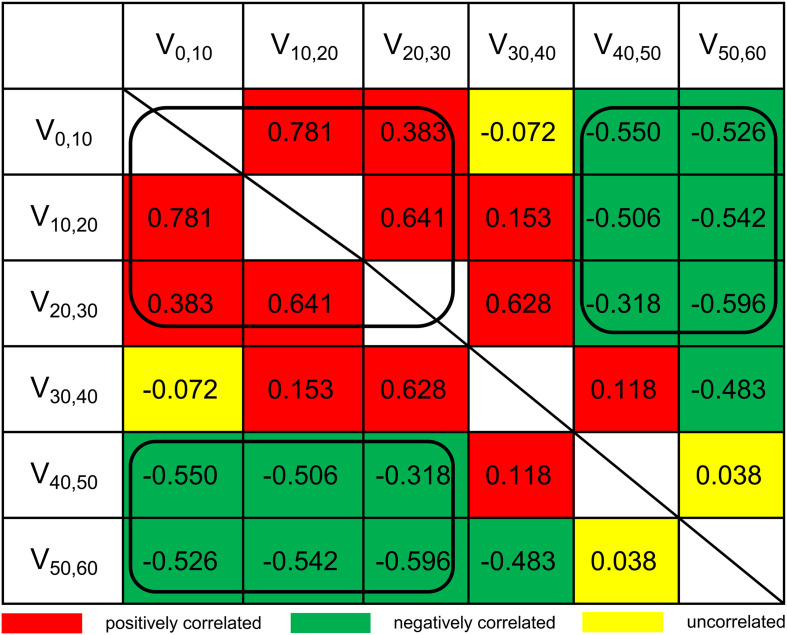
Pairwise Spearman correlation coefficients between dosimetry parameters. Va,b, the percentage of thyroid volume receiving irradiation doses of a–b Gy.